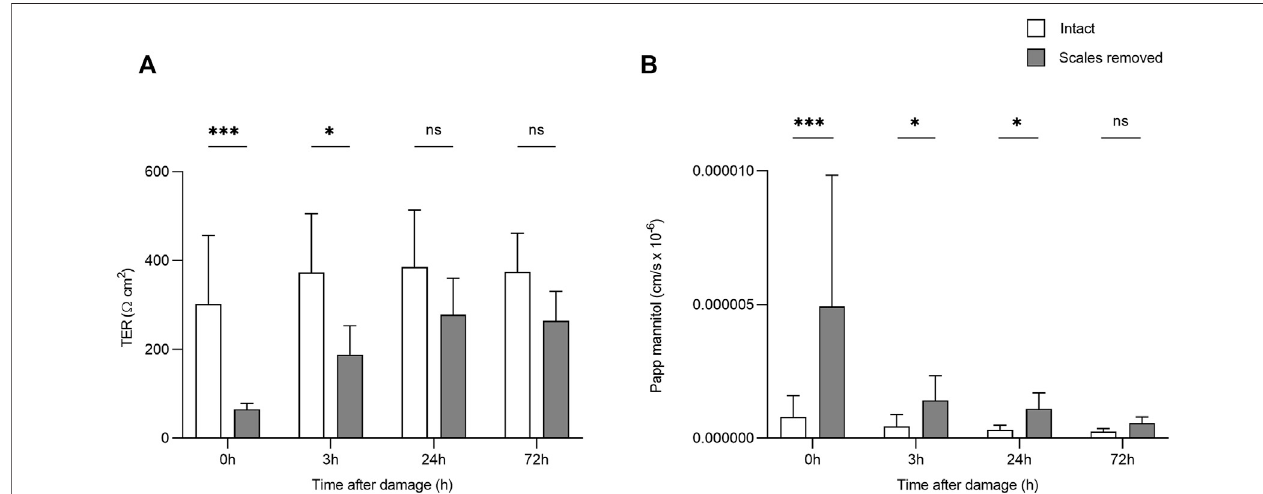
FIGURE2| Barchartshowing (A) transepithelialresistance(TER)and (B) 14 C-mannitolP app (Log-transformed)inintactskin,andskinwithoutscalesbutwithintact dermis. Higher TER values indicate greater barrier function/lower transepithelial permeability, while higher 14 C-mannitol P app values indicate greater epithelial permeability. Bars represent mean and whiskers indicate standard deviation. Signi fi cant differences based on post-hoc Tukey tests are denoted with asterisks (*** p < 0.001; * p < 0.05; ns, no signi fi cant